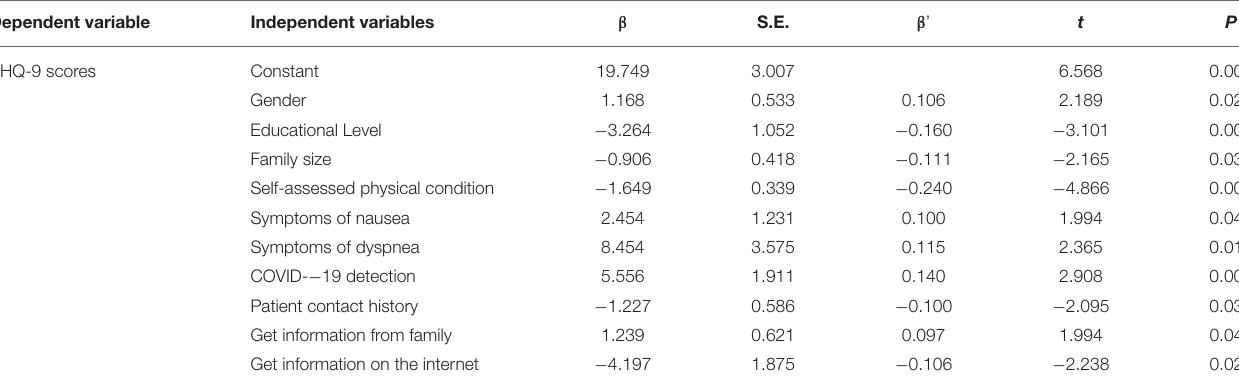
TABLE 6 | Stepwise regression analysis of the factors of depression due to COVID-19 among local South Korean students. Dependent